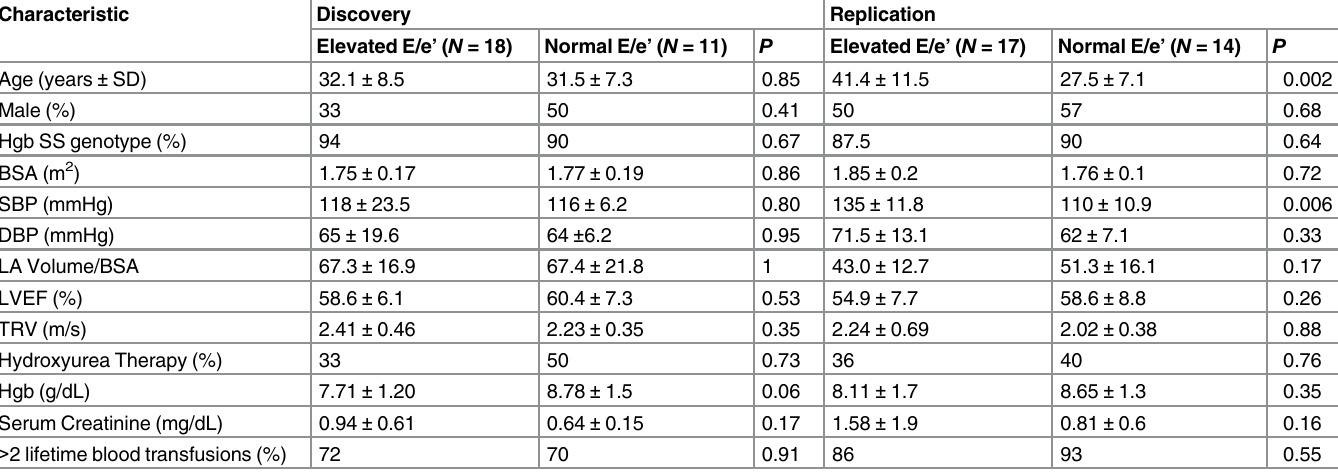
Table 1. Patient characteristics within SCD discovery and replication cohorts.